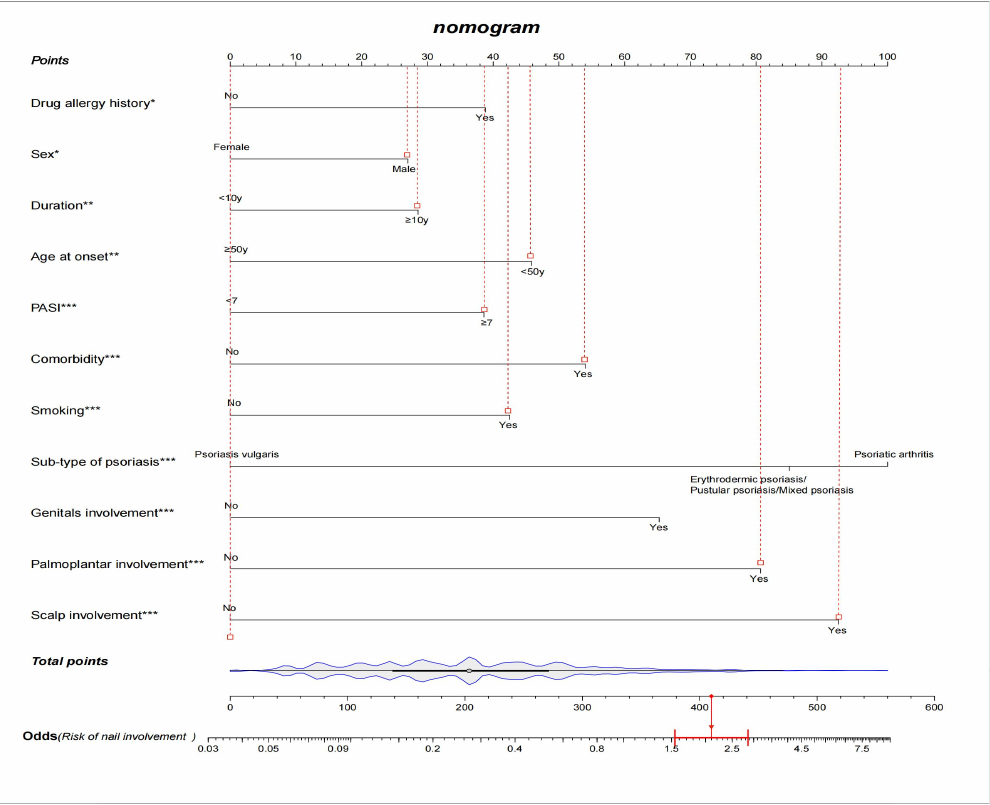
Figure 1. A constructed nomogram for nail involvement prediction of a patient with psoriasis. Density plot of total points shows their distribution. For categorical variables, their distributions are reflected by the length of the line. All variables were ranked according to the p value (* p value ≤